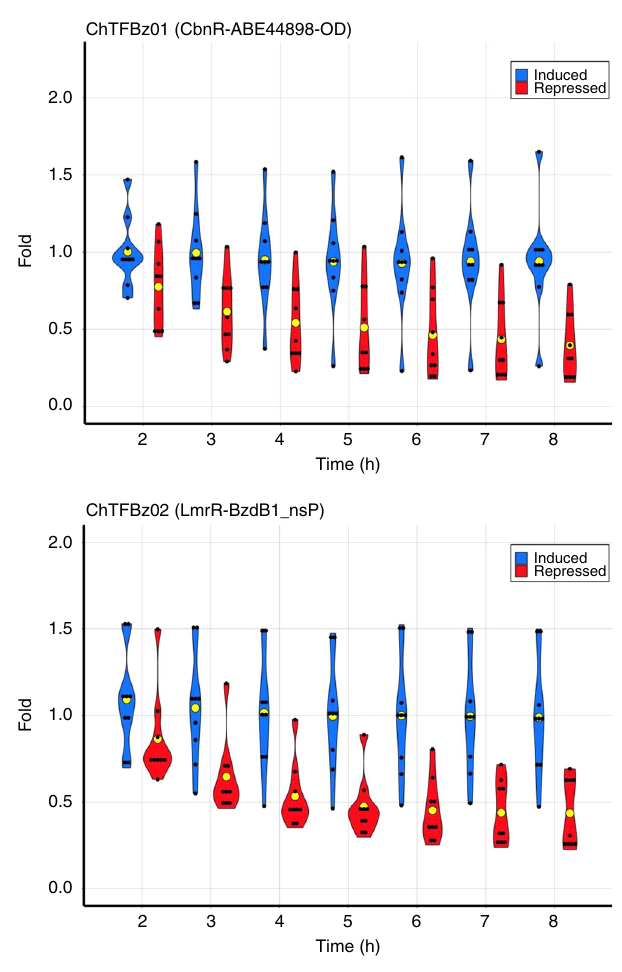
Fig. 4 In vivo validation of ChTFBz01 (CbnR-ABE44898-OD) and ChTFBz02 (LmrR-BzdB1_nSP). Time course showing relative GFP fl uorescence of AYC ChTFBz01 and AYC ChTFBz02 strains grown